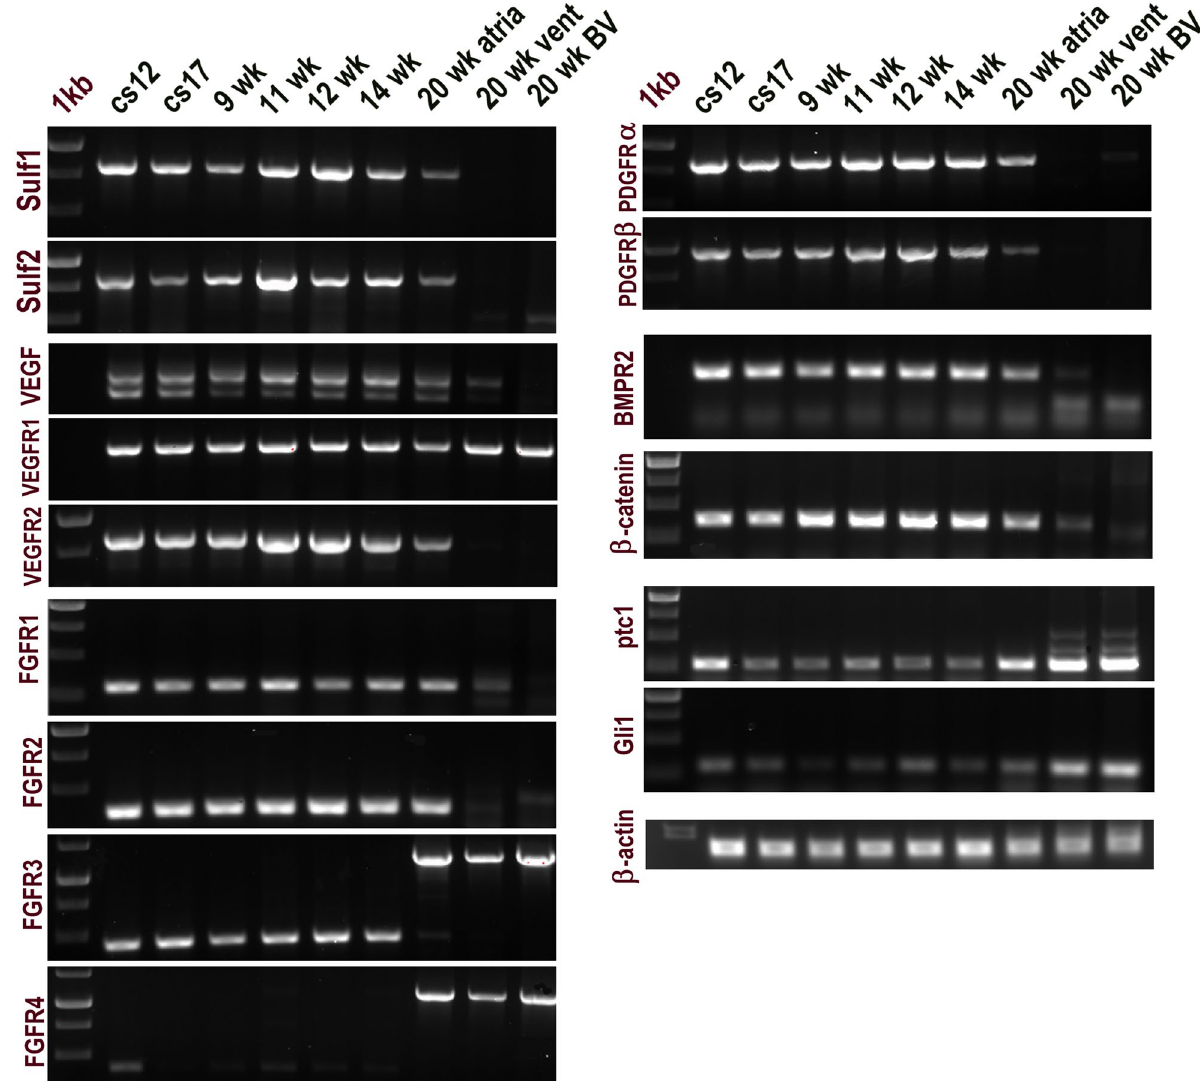
Figure 1. RT PCR analysis showing expression levels of different mRNAs as indicated during different stages of human myocardial development. BV blood vessel, vent ventricle, cs carnegie stage, wk Marked TGFβ and SULF1/SULF2 up-regulation in atrial haemangiosarcomal endothelial cells. As is the case with most haemangiosarcoma cells metastasising to different tissue types, right atrial haemangiosarcoma was characterised by abundance of small and large dysfunctional clusters of abnormal endothelial tubes identified from vWF and VE-cadherin co-expression but lacking smooth muscle cell recruit- ment (Fig. 6). Many such blood vessel clusters also included collections of blood cells, mainly erythrocytes that showed little resemblance to normal blood vessels due to virtual absence of mural cell recruitment (Fig. 6) and fragility of such structures characterising regional haemorrhages. High levels of Smad2/3 activation in such dys- functional blood vessels compared with normal blood vessels indicated increased TGFβ cell signalling in such endothelial cell tubes (Fig. 6). Sulf1/Sulf2 and cell signalling responses of HMec1 endothelial cells to in vitro hypoxia. To examine if some changes in cell signalling or Sulf1/Sulf2 levels during in vivo ischemia were also apparent during in vitro hypoxia, we exposed HMec1 human endothelial cells to 100 µM and 300 µM CoCl2 chemical hypoxia for different lengths of time to examine changes in VEGF levels. CoCl2 induced hypoxia was confirmed by rapid HIF1α activation (Fig. 7, Table 2 and Supplementary Information). The control HMec1 cells only express a trace amount of the shorter VEGF 120 isoform that at 100 µM only increased a little at 3 days without any up-regulation of VEGF 165 isoform, the most potent isoform, or recruitment of VEGFR1 unlike rapid changes observed in both VEGF 120 and VEGF 165 isoforms and recruitment of VEGFR1 at 300 µM CoCl2 (Fig. 7 and Table 2). Sulf1/ Sulf2 changes also became apparent under such conditions as Sulf1 levels rapidly increased upon hypoxia that later dropped down to low levels. Sulf2, in contrast, however, showed delayed and only gradual up-regulation of